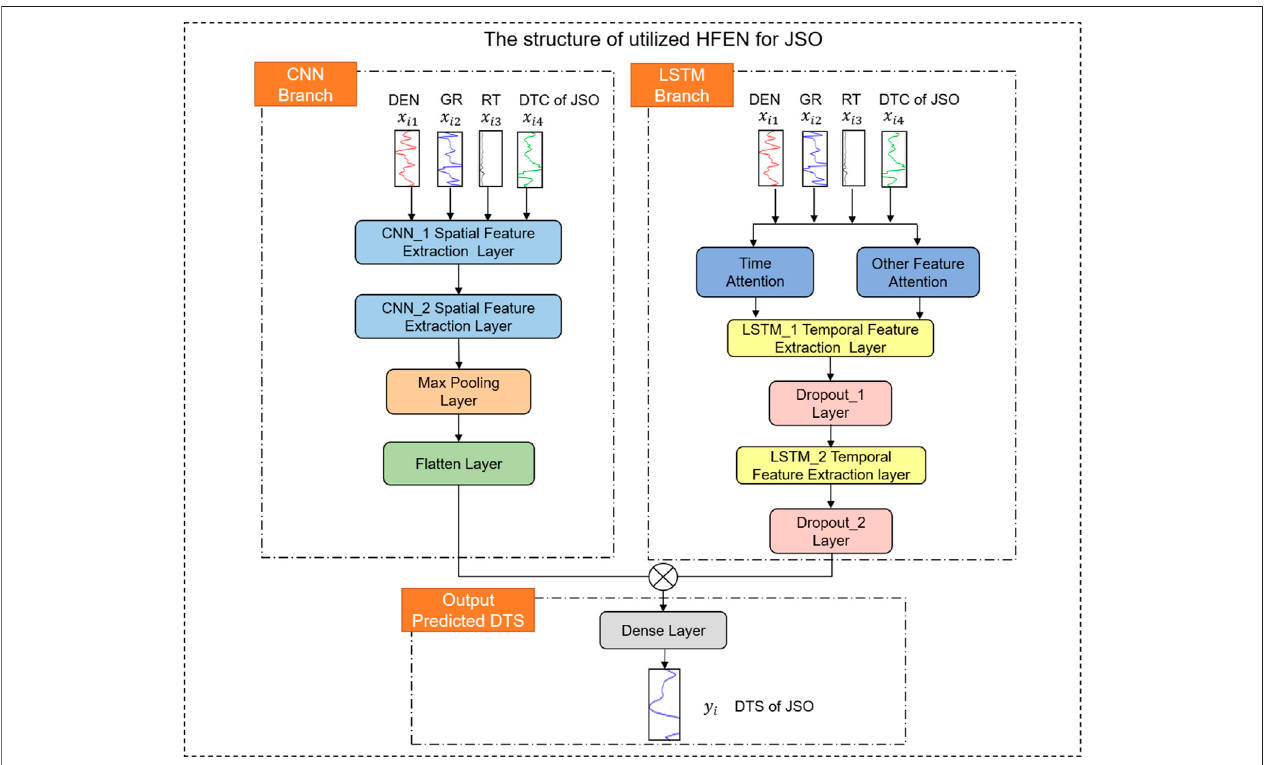
FIGURE 10 | The structure of utilized HFEN for JSO.